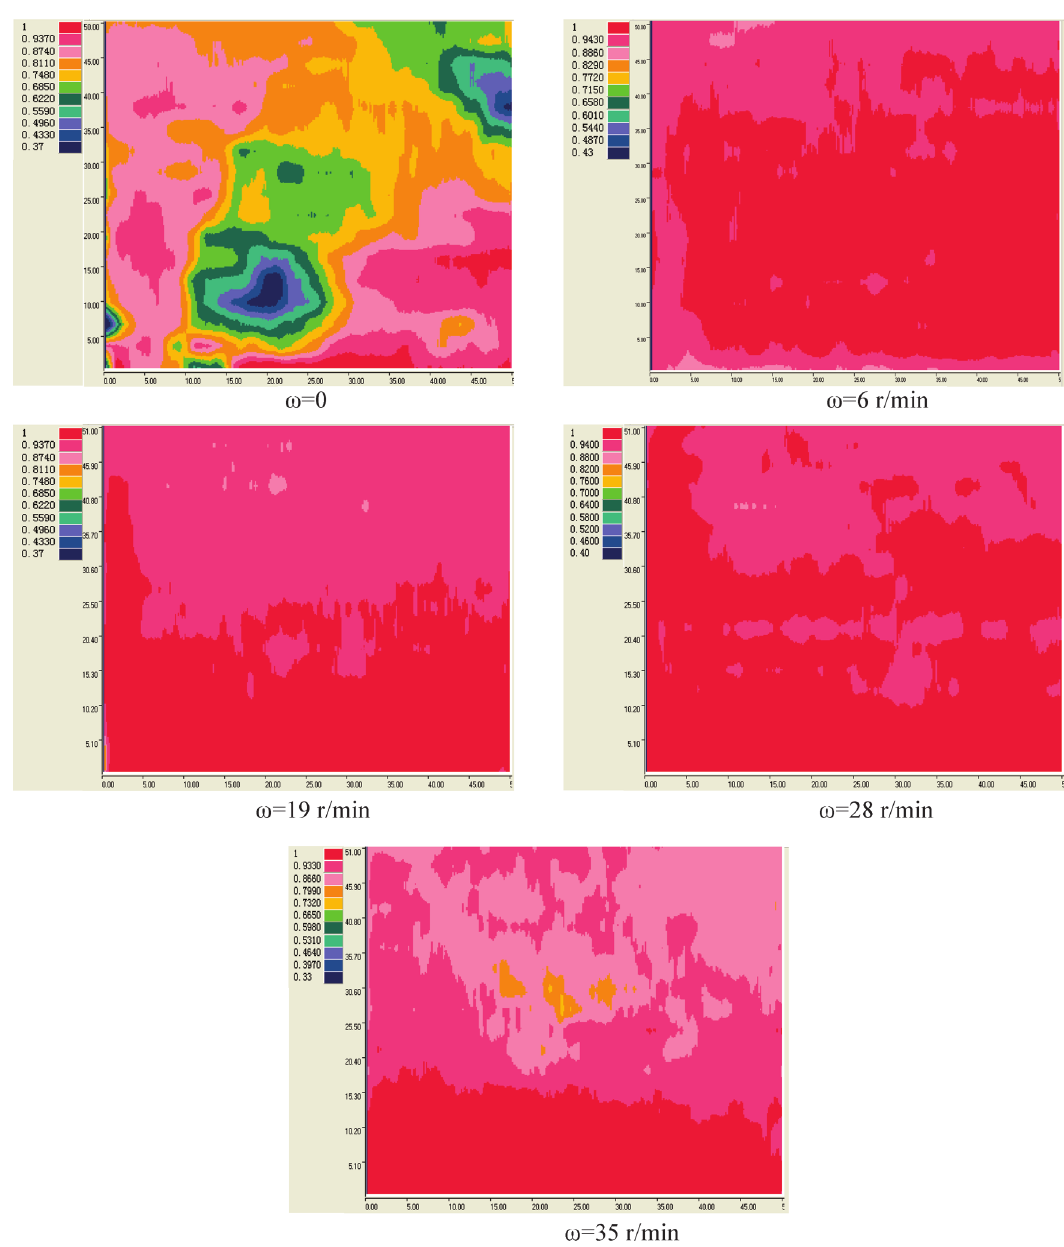
Fig. 7: Effects of mould rotation on compact density of electroslag